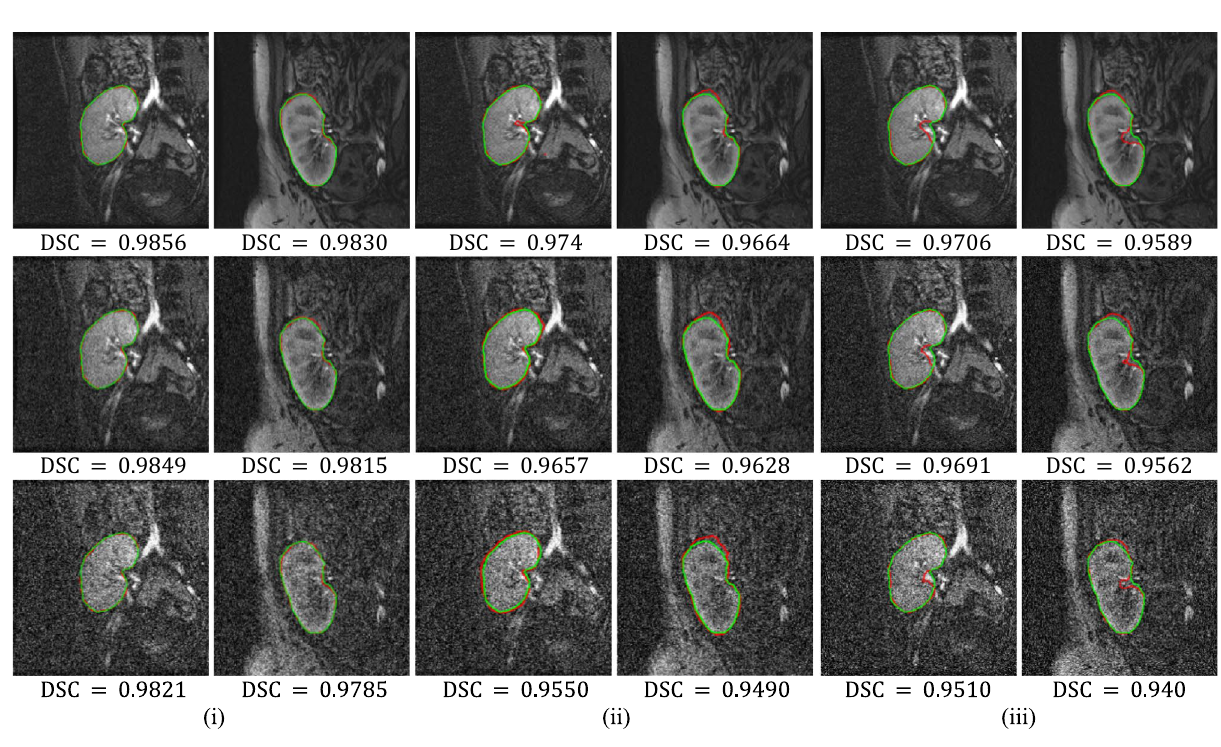
Figure 5. Comparison between the FML method vs U-Net and BCDU-Net models on noisy DCE-MRI images. Segmentation results are shown in red for the FML method in (i), U-Net model in (ii), and BCDU-Net model in (iii). The ground-truth segmentations are shown in green, with DSC reported beneath each result. First row shows original images, second row shows images with noise variance 0.01, and third row shows images with noise variance